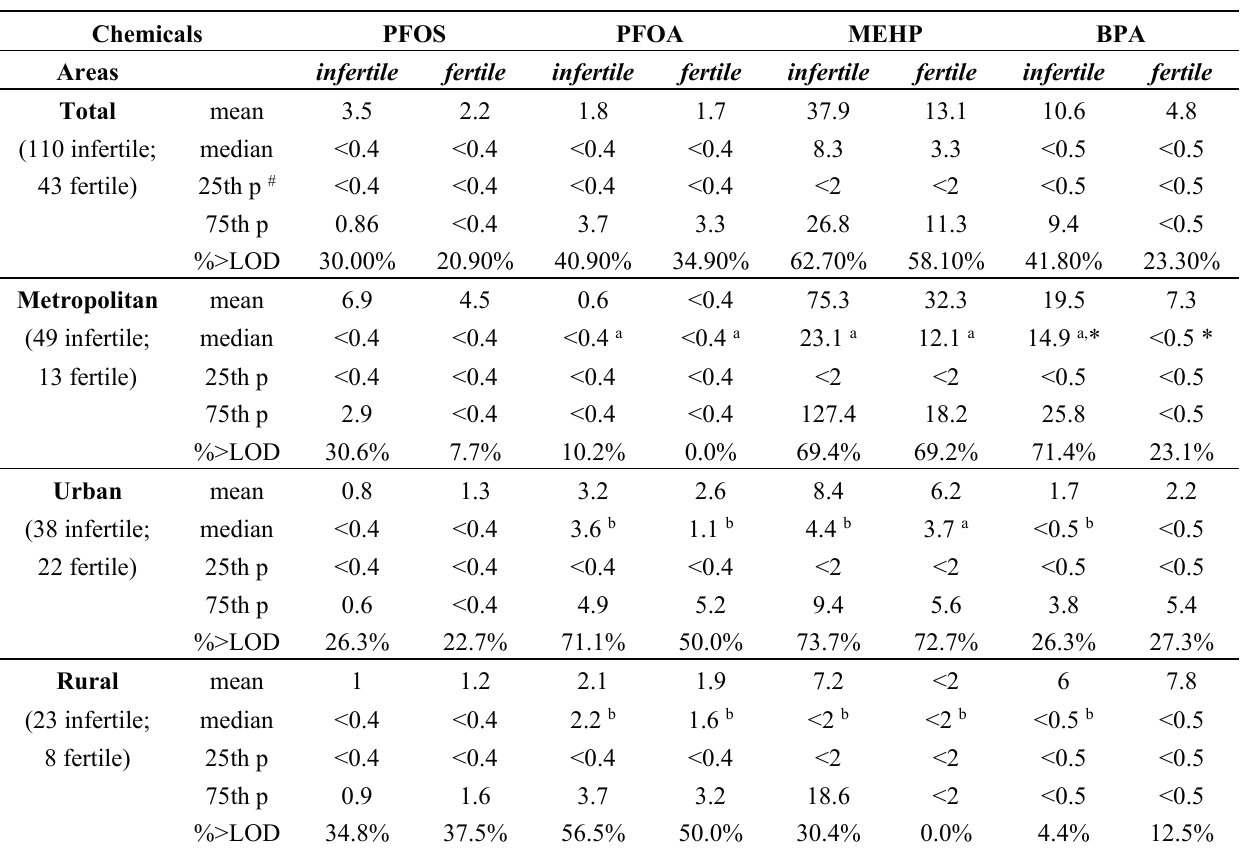
Table 3. Analytical values of PFOS, PFOA (ng/mL blood), MEHP and total BPA (ng/mL serum) in enrolled women grouped by area of residence and subject